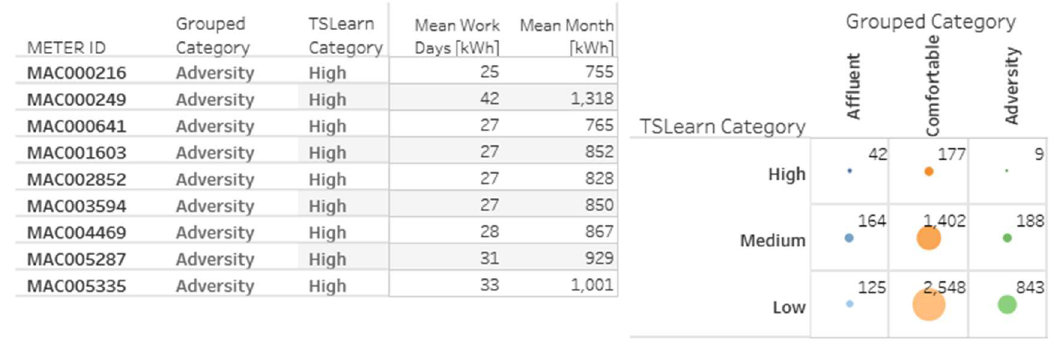
Figure 14. Households from the adversity category with high energy consumption.